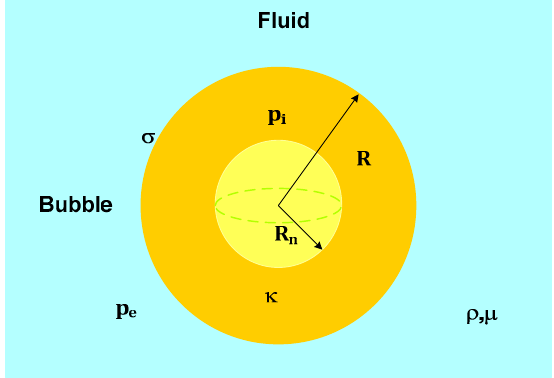
Figure 8. Physical parameters of the bubble in the Rayleigh model. R is the radius of the bubble. R n is the radius of the sphere at rest. p i is the pressure inside the bubble. p e is the external pressure of the fluid. κ is the polytropic exponent of the gas inside the bubble. ρ is the bulk density. µ is the dynamic viscosity. σ is the surface tension of the fluid.